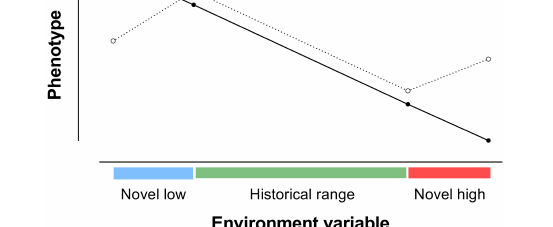
FIGURE6 Reaction norms for an animal with the same slope of reaction norm in historical and novel environmental conditions ( ) and for an animal with different slopes in novel conditions in comparison with an historical range of conditions ( ). The reaction norm for the second animal in historical conditions did not predict the reaction norm in novel conditions [adapted from Ghalambor et al.